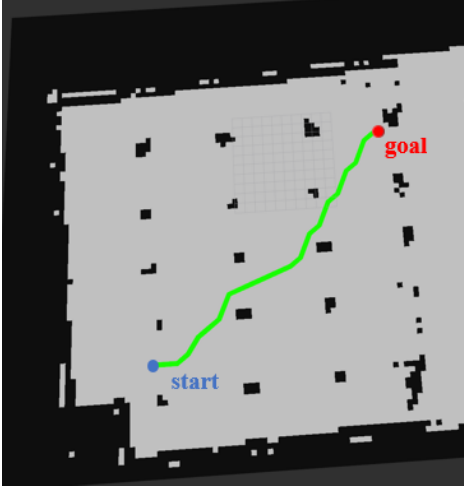
Figure 18. The path planned by the middle planner.